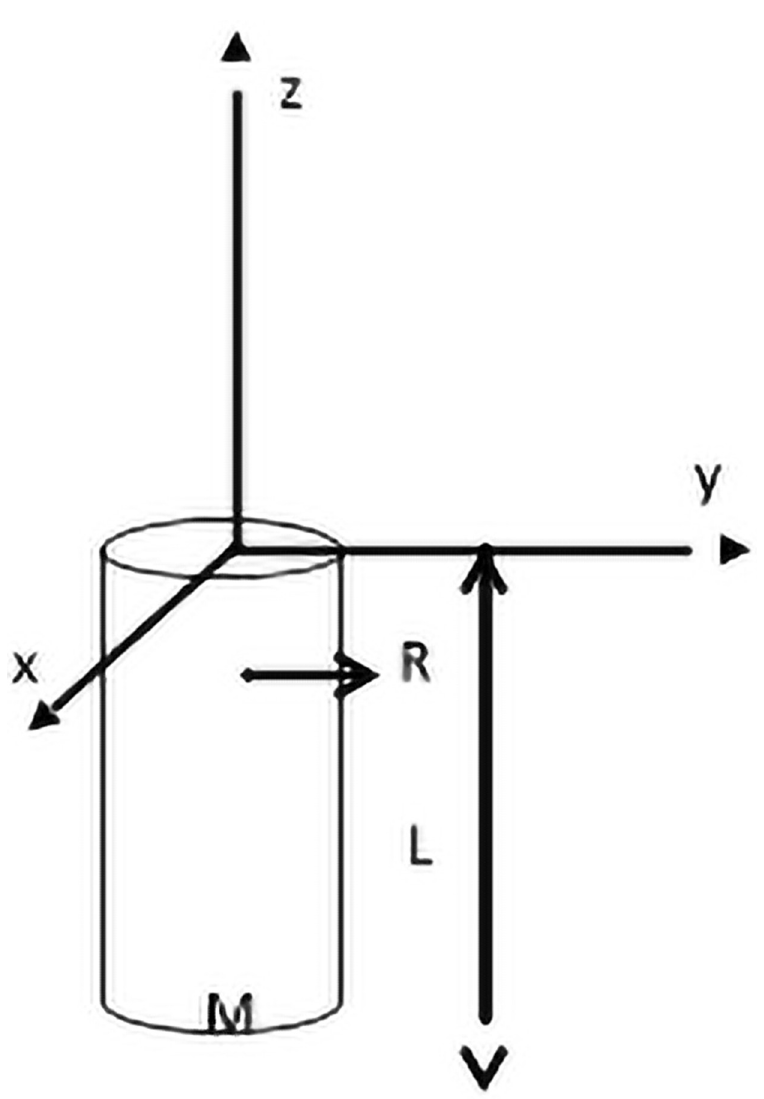
Fig 7. Moment of inertia of a cylinder. A cylinder of length L, radius R, and mass M and the coordinates (x,y,z) located with origin at the center of an endface.